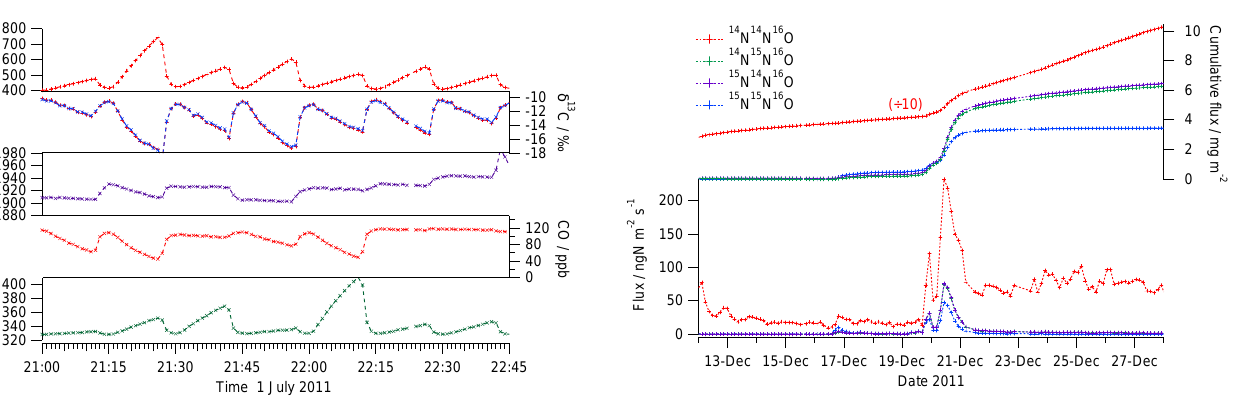
Fig. 13. Time sequence of mole fractions of CO 2 , CH 4 , N 2 O, CO and δ 13 C in CO 2 measurements from seven sequential chamber clo- sures in the Quasom experiment, 1 July 2011. See text for details.